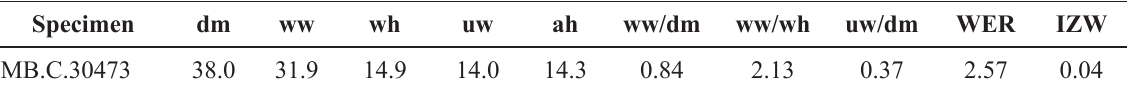
Table 11. Conch dimensions (in mm) and ratios of Vestinautilus bicristatus sp.